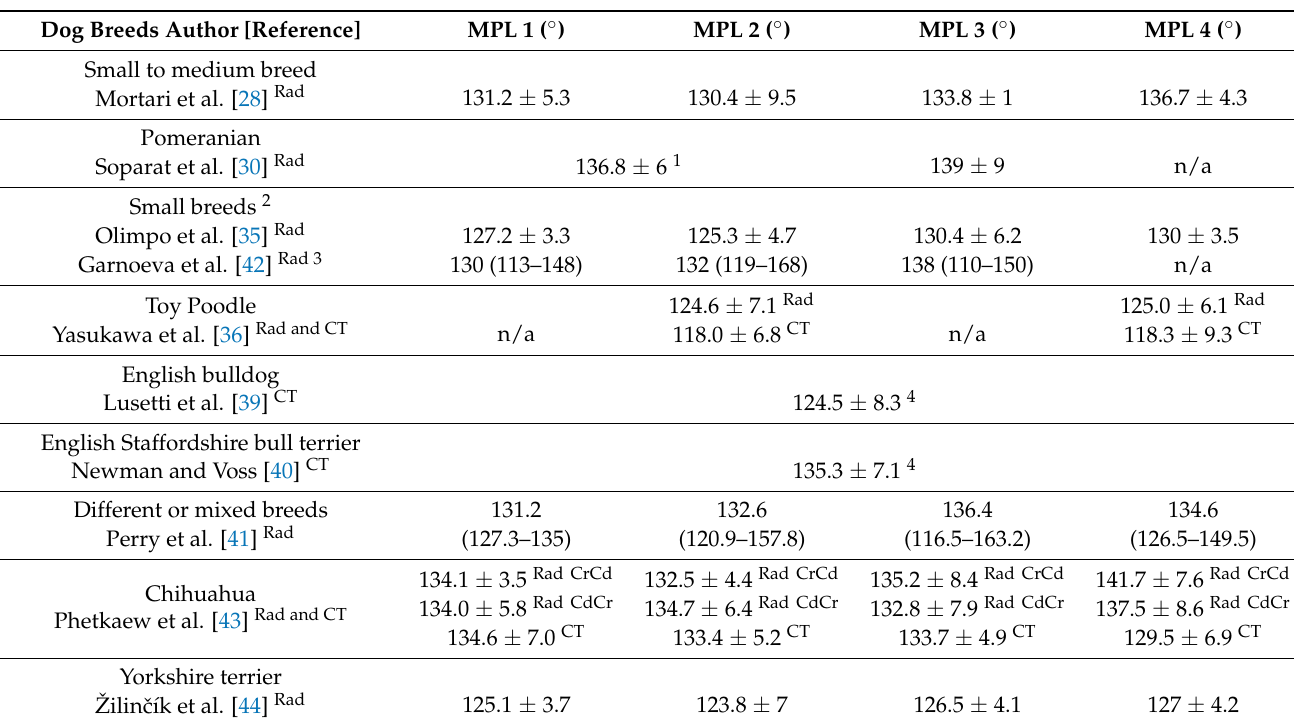
Table 5. Mean ± standard deviation of femoral inclination angle in dogs with different grades of medial patellar luxa- tion